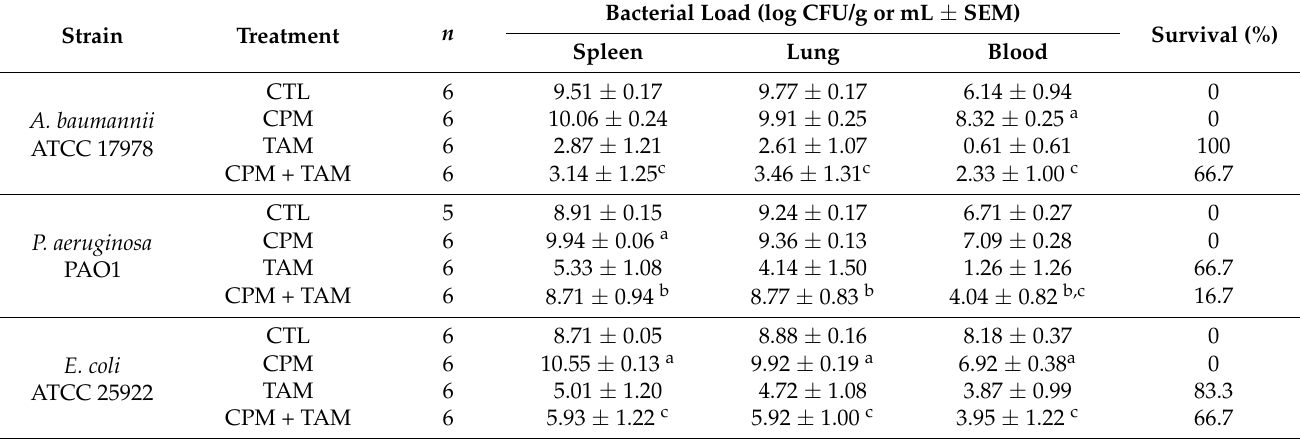
Table 1. Tamoxifen shows therapeutic efficacy in immunocompetent and immunosuppressed murine models of peritoneal sepsis by Gram-negative